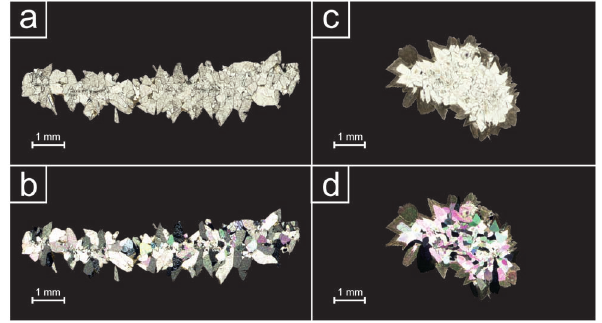
Fig. 5. Thin section photomicrographs of aggregates and individu- als of crystals with rhombohedral faces at locality 1: (a, b) sunken rafts with rhombohedral crystals on both sides (b cross-polarized light). (c, d) Calcitic aggregates with translucent crystals in the inte- rior and with darker (inclusion-rich) overgrowth (d cross-polarized